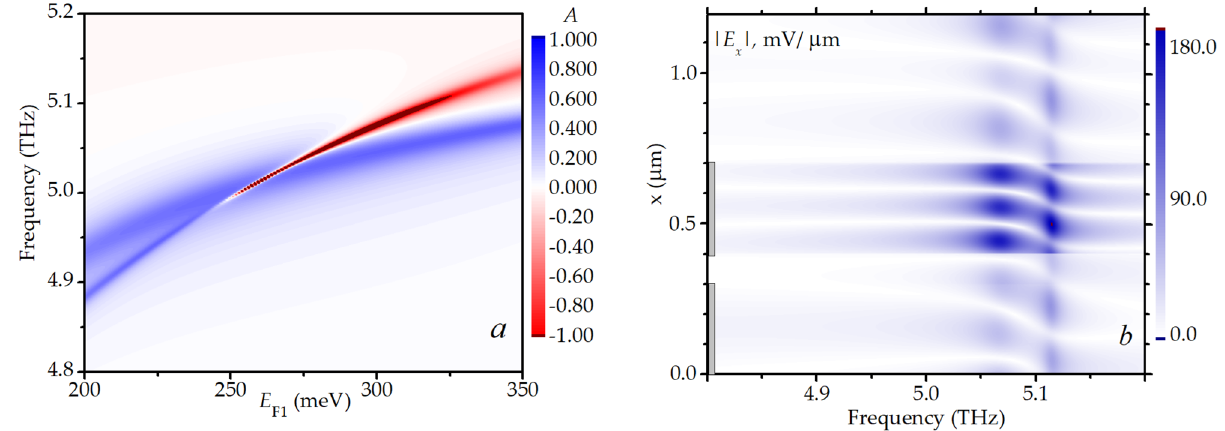
Figure 4. ( a ) Absorption coefficient vs the frequency and the Fermi energy in the upper graphene under one subgrating fingers with fixed value of Fermi energy E F2 = 110 meV under the other subgrating fingers. ( b ) The spatial distribution of the x- component of the electric field amplitude (absolute value) over the unit cell of the DGGGH in the passive graphene layer for the fixed Fermi energy values E F1 = 330 meV and E F2 = 110 meV a little shifted from the values corresponding to the plasmon mode intercrossing. The positions of the gate fingers are shown by the grey